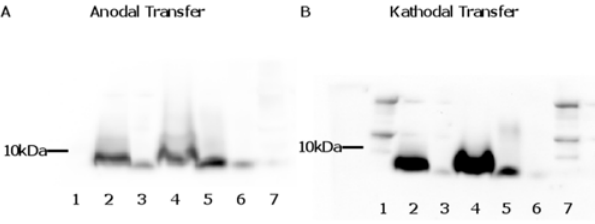
Figure 4. Western blot analyses of LEKTI-2 antibodies. Proteins were separated in a 16.5% SDS-tricine polyacrylamide gel containing 8 M urea and blotted from both, the anode (left panel) and the cathode (right panel) using protein transfer at pH 10.5. Recombinant and natural LEKTI-2 used here have been HPLC-purified, stored below 2 70 u C and used immediately prior to experiments unless otherwise stated. Lanes 1 and 7: Precisions Plus Protein Dual Color standards Biorad (it includes peroxidase-active markers), each 3 m l; lane 2: stratum corneum extract, 20 m l; lane 3: rLEKTI-2 (200 ng); lane 4: stratum corneum extract, 40 m l; lane 5: natural LEKTI-2 from stratum corneum extract (off RP-8-HPLC, see Fig. 1A), 30 m l; lane 6: rLEKTI-2 (200 ng). WB analyses performed with LEKTI-2 antibodies, pretreated for 1 h with 20 m g r LEKTI-2, did not show any LEKTI-2 immunostaining, which further confirms specificity of the LEKTI-2 antibodies. Note that cathodal transfer seems to be more efficient than anodal protein transfer. A representative out of three independent experiments is shown.